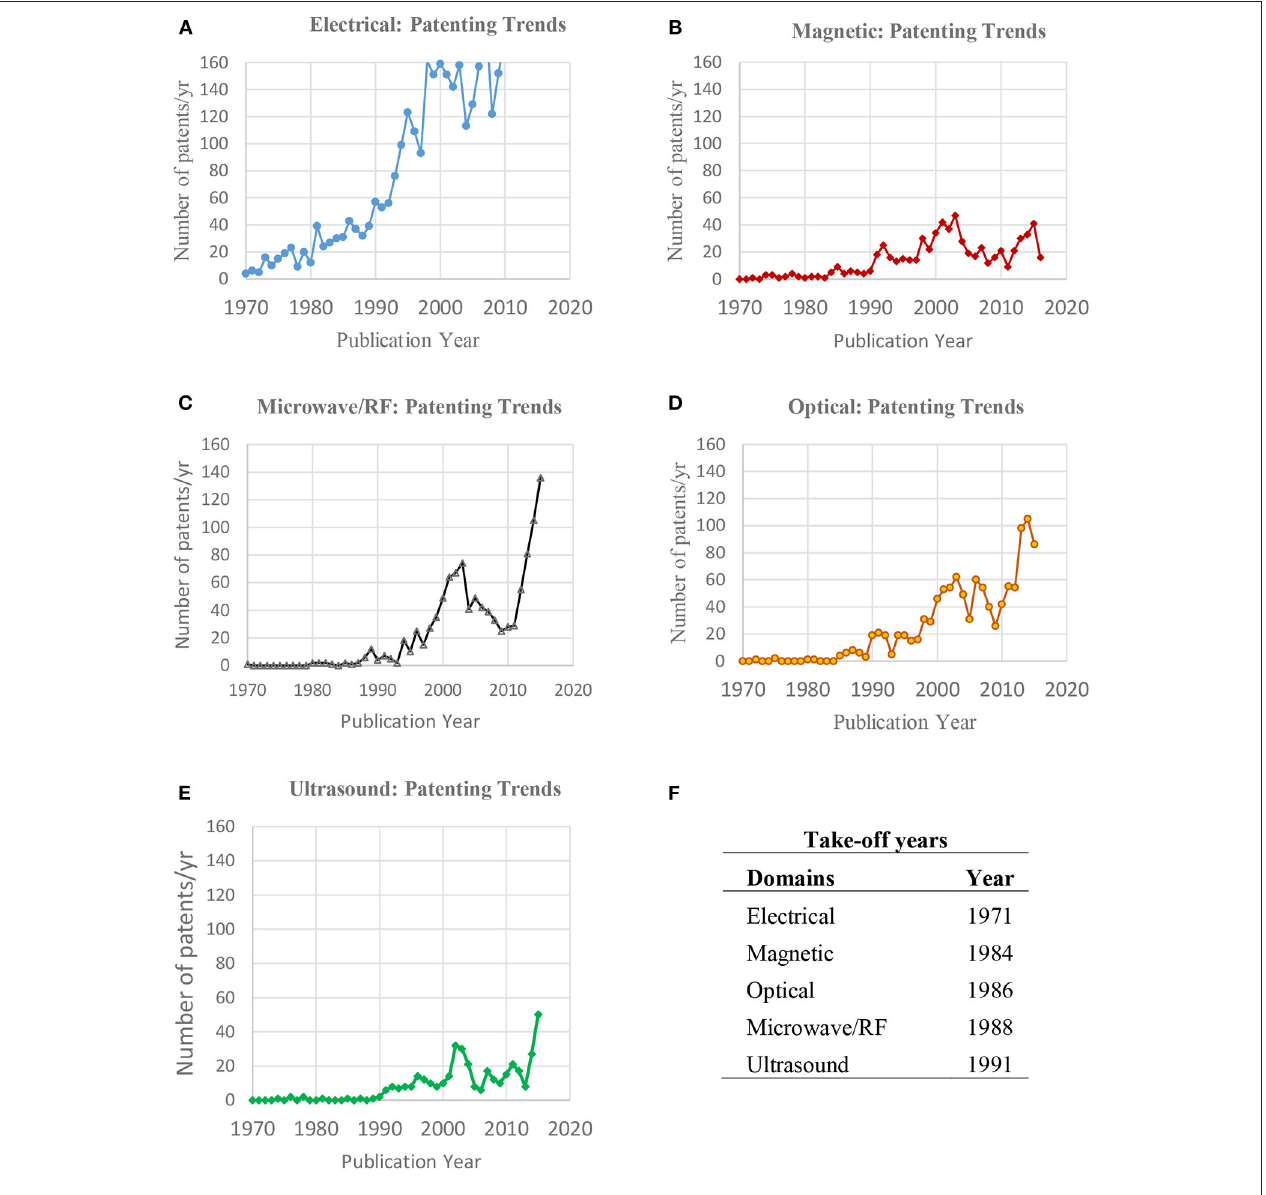
FIGURE 4 | (A–F) Patenting trends in the five energy-based therapeutic domains—annual number of patents in (A) electrical, (B) magnetic, (C) microwave/radiofrequency (MW/RF), (D) optical, and (E) ultrasound. (F) Shows the years for each of the five domains when at least five patents per year were granted in the domain for the first